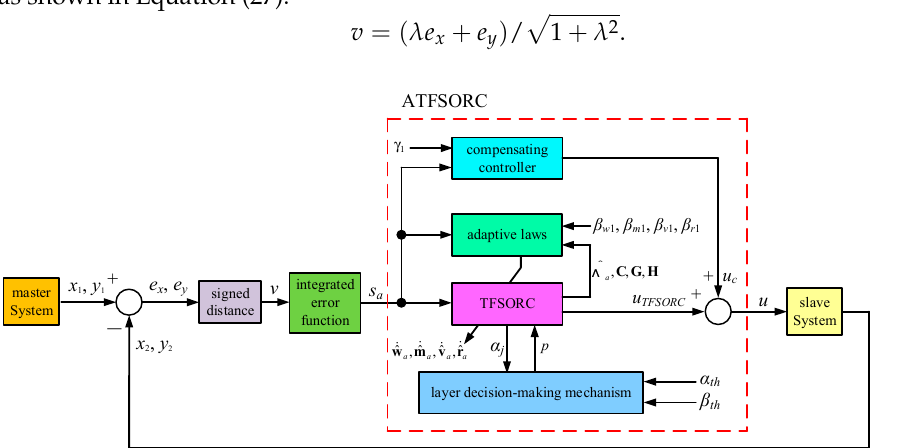
as shown in Equation (27). shown in Equation (27).